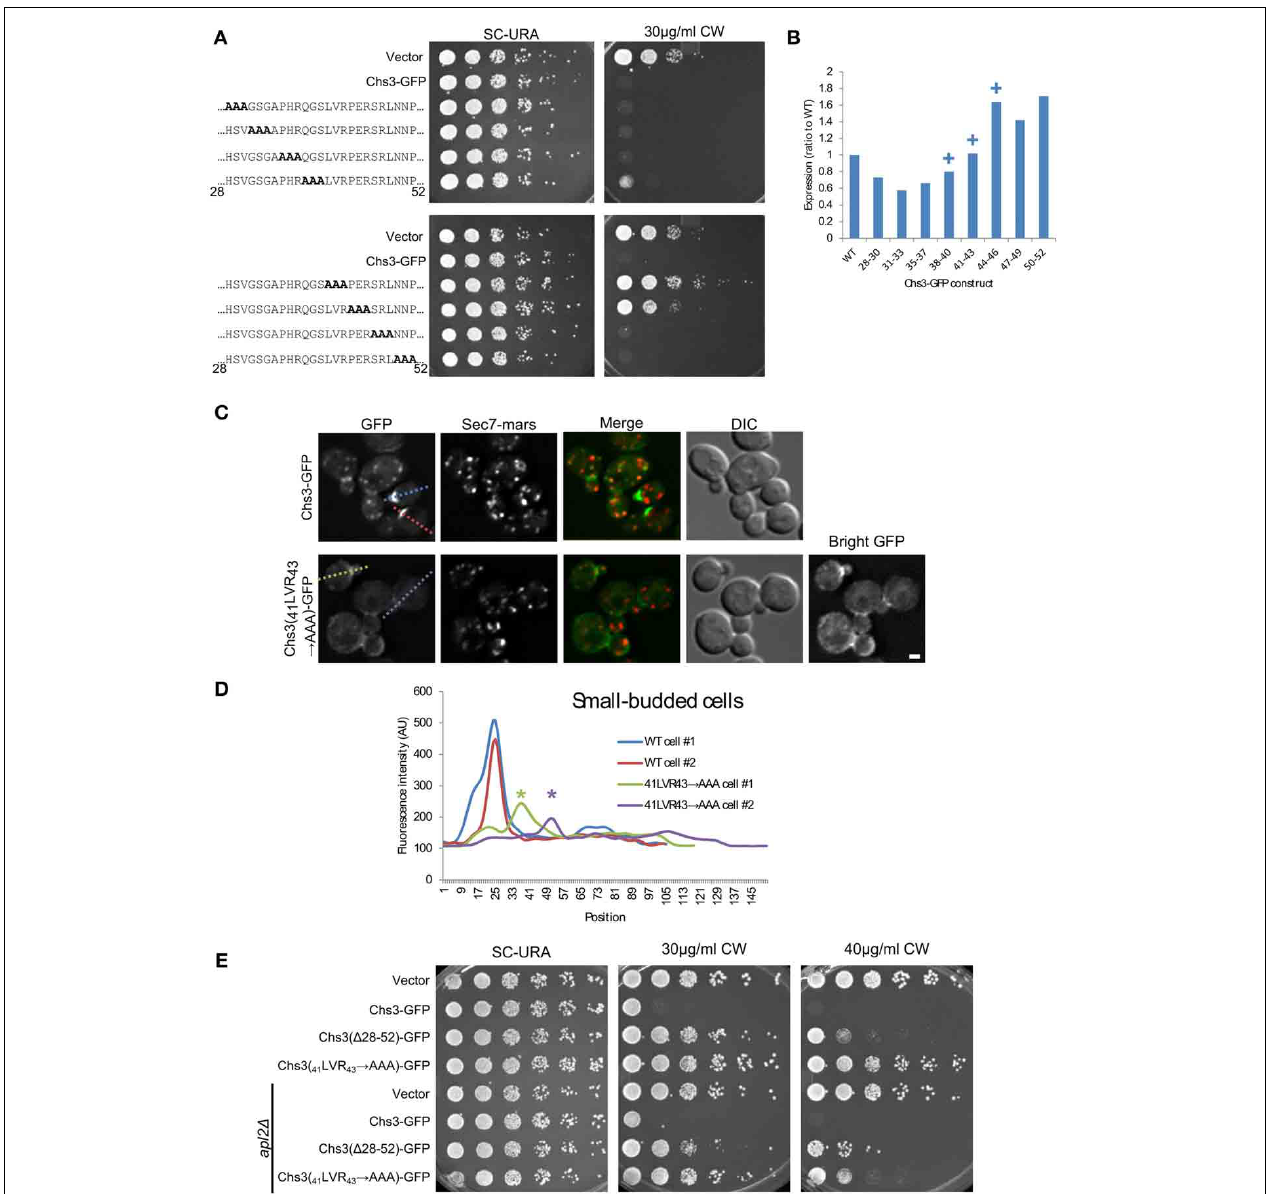
FIGURE 4 | Deletion of Chs3 residues 41–43 has a strong defect in transport. (A) Chs3-GFP plasmids containing alanine scanning mutants were transformed into a chs3 (cid:2) SEC7-Mars strain and plated on indicated concentrations of CW. Plates were imaged after 2 days at 30 ◦ C. See also Figure S2 for additional CW concentrations. (B) Protein expression level of alanine-scanning Chs3-GFP constructs relative to wild type as calculated from the α -GFP Western blots in Figure S1, normalized to loading control. Mutations that confer CW resistance phenotypes are marked with ( + ).